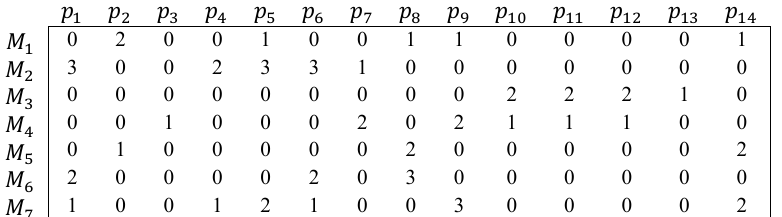
Exceptional Displacement Displacement Time parts of parts of machines